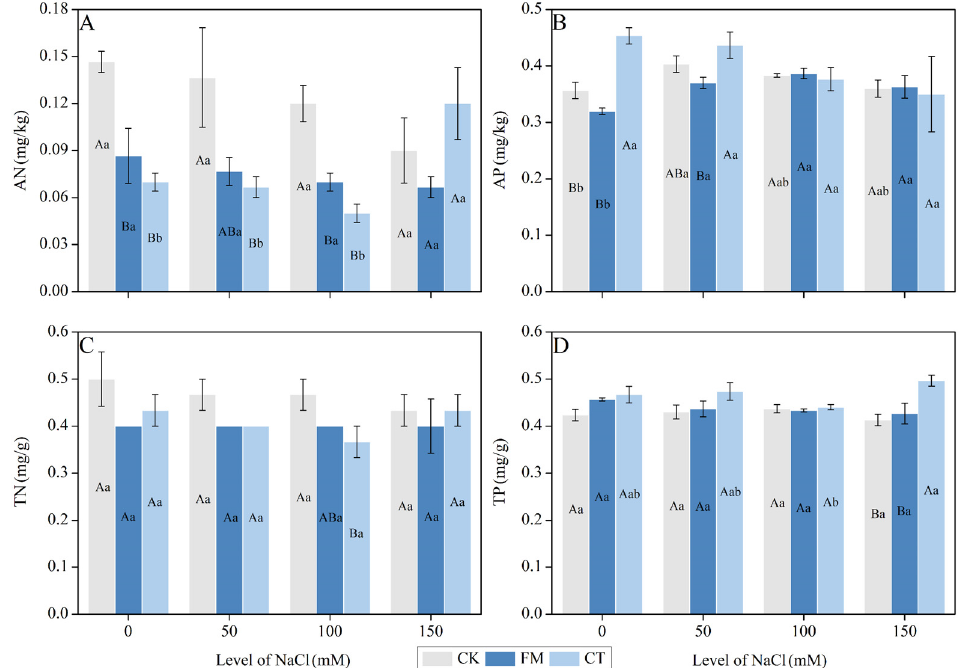
Figure 5. Variations in soil nitrogen and phosphorus contents between treatments. ( A ) soil alkali-hydrolyzable nitrogen content under different treatments; ( B ) soil available phosphorus content under different treatments; ( C ) soil total nitrogen content under different treatments; ( D ) soil total phosphorus content under different treatments. Meanings of letters and error bars are consistent with Figure 1. AN, soil alkali-hydrolyzable nitrogen; TN, soil total nitrogen; AP, soil available phosphorus; TP, soil total phosphorus. Table 1. Two-way analysis of variance on indices of G. sinensis Lam. root system and soil.